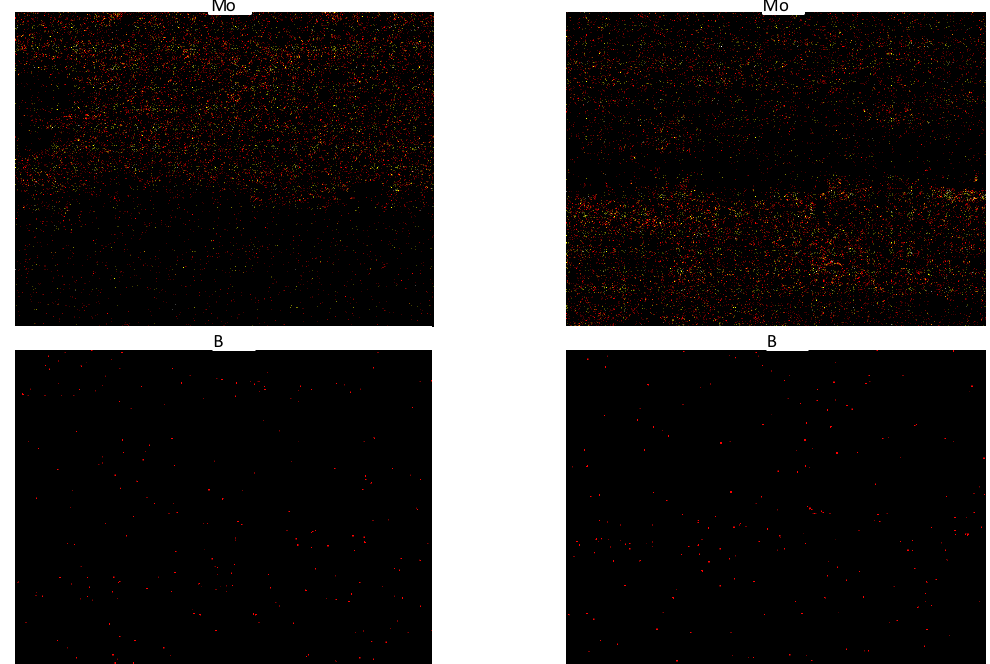
Figure 11. Maps of the distribution of elements in the surface layer SAE-48 bearing alloy; ( a ) 15W-40 engine oil, ( b ) 5W-40 engine oil.